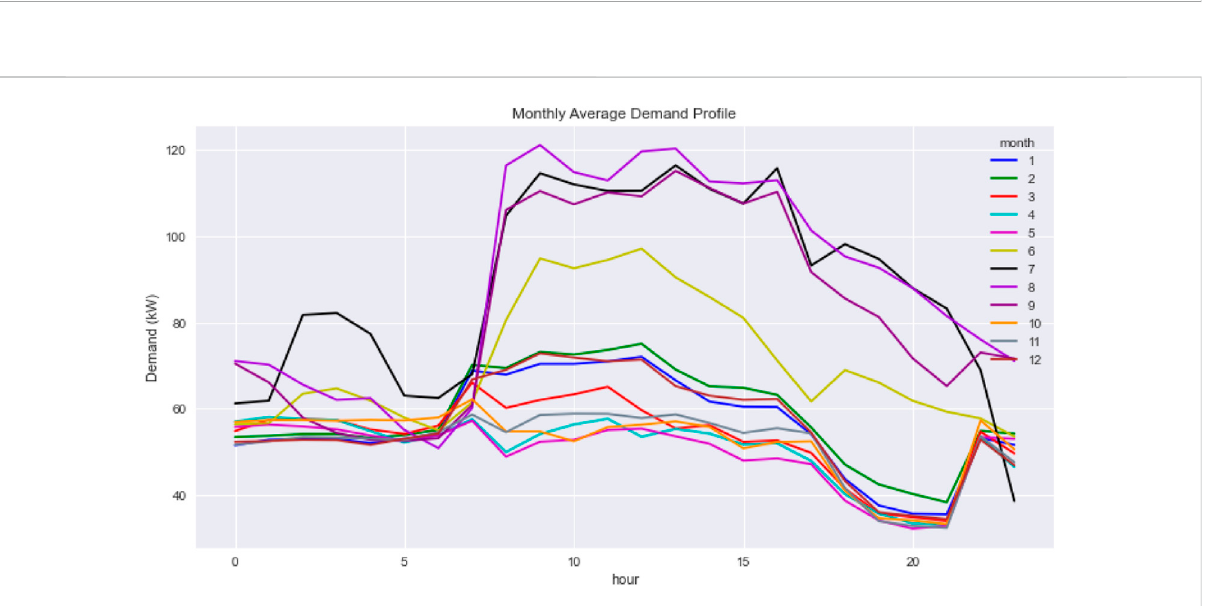
FIGURE 4 Monthly average commercial demand pro fi